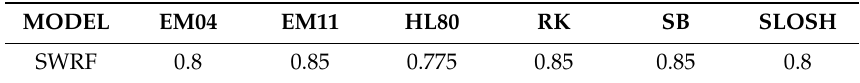
Table 2. Surface wind reduction factor (SWRF) employed for the wind adjustment of di ff erent parametric wind